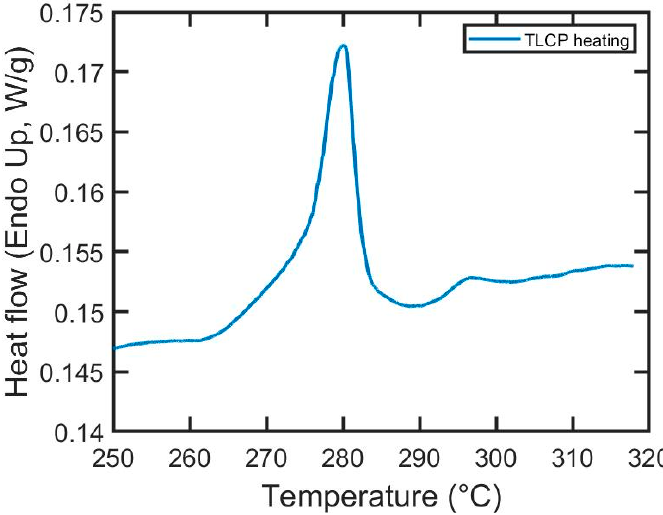
Figure 4. DSC heating scan of the TLCP material with the heating rate of 10 °C/min .